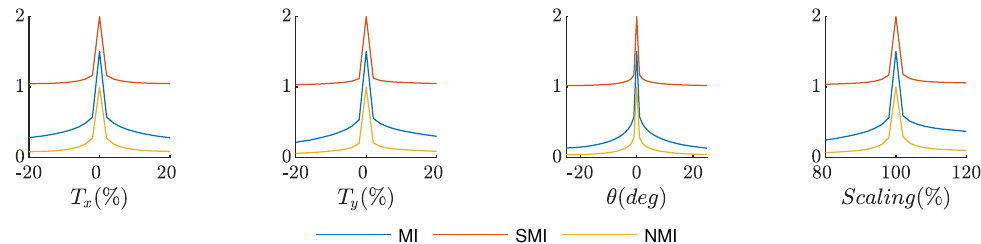
Figure 6. Local response of MI-based metrics to independent camera movement components under idealized conditions, i.e., when each video frame is compared to the stable version of itself. Averaged values along all studied video sequences. Camera movement components are: translation in the X direction ( T x ), translation in the Y direction ( T y ), rotation ( θ ) and